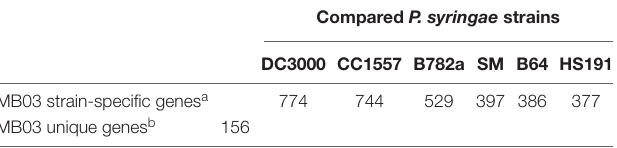
TABLE 1 | Strain-specific genes of P. syringae MB03 compared with other reference